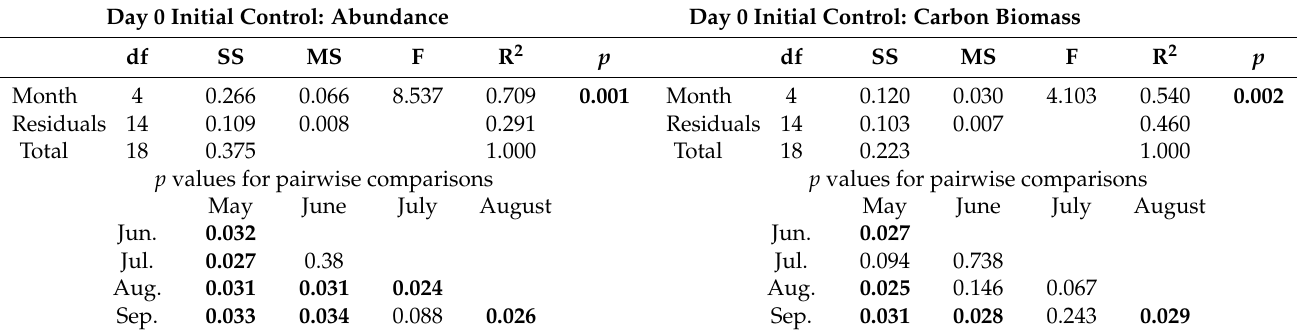
Table 1. Results of PERMANOVA and pairwise post hoc comparison tests for monthly